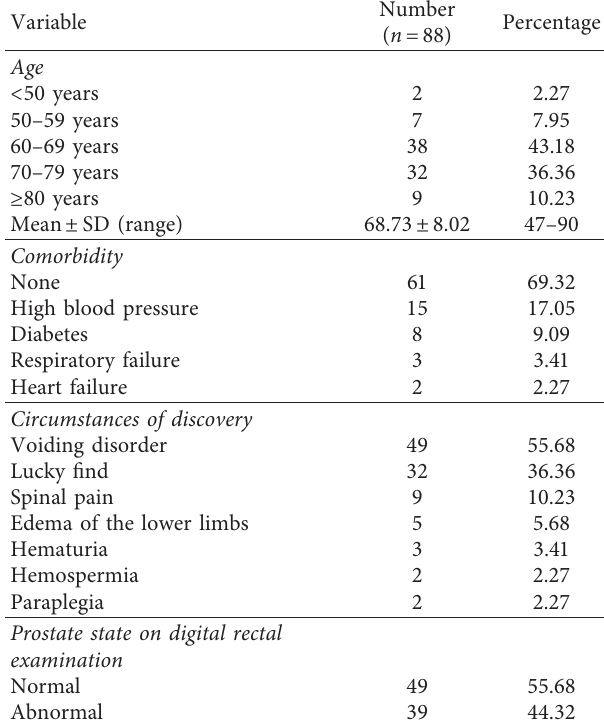
Table 1: Demographic and clinical characteristics of the